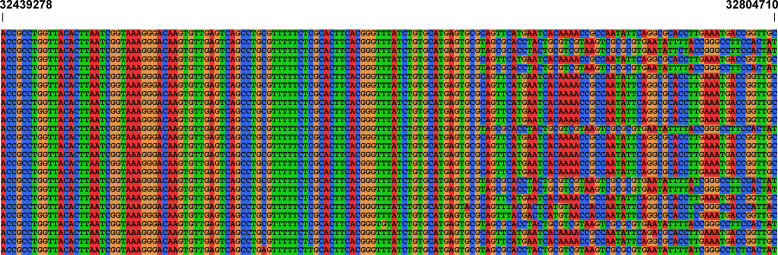
Haplotype Alignment of the Region Presenting Differing Variation RatesThe alignment covers the centromeric side of the DR–DQ 158-kb DNA segment (left half, low variation) and the adjacent DNA segment (increased variation). Coordinates refer to Chromosome 6 build NCBI35. Rows represent the allelic state for 26 single chromosomes with the same DRB1*1501-DQA1*0102-DQB1*0602 (DR15–DQ6) haplotype at successive SNPs which are represented by columns (A, red; C, blue; G, orange; and T, green). Identity is interrupted at a position perfectly matching with a recombination hotspot coordinate [5,53] represented as hotspot number 2 in Figure 4.